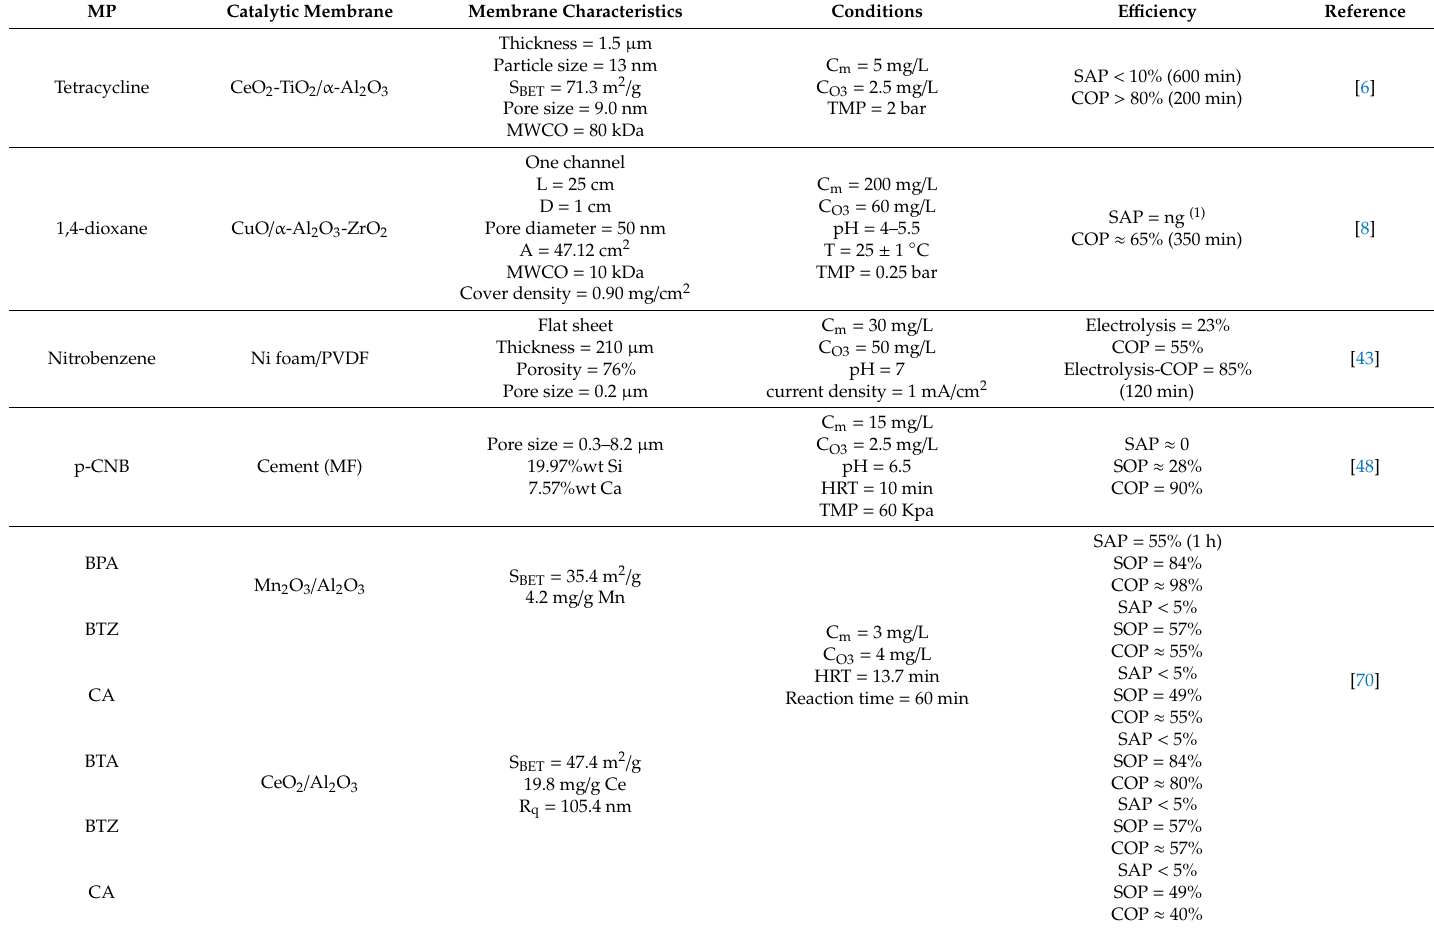
Table 4. Summary of catalytic membranes (main characteristics, conditions, e ffi ciency) used for MPs